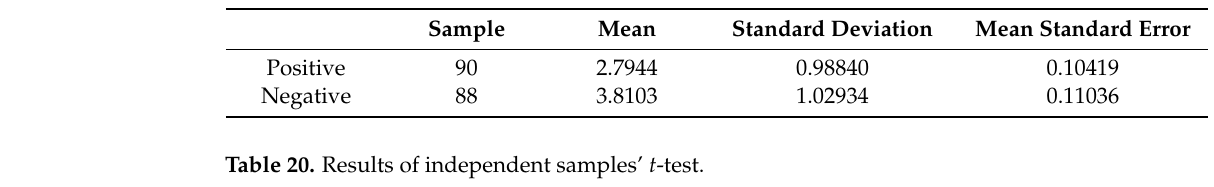
Table 19. Descriptive statistics of two groups.